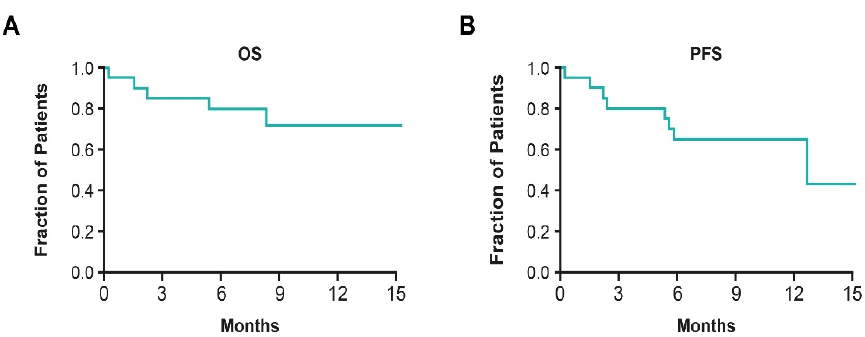
Figure 7. ( A ) OS and ( B ) PFS in patients with PDAC receiving TTFields therapy concomitant